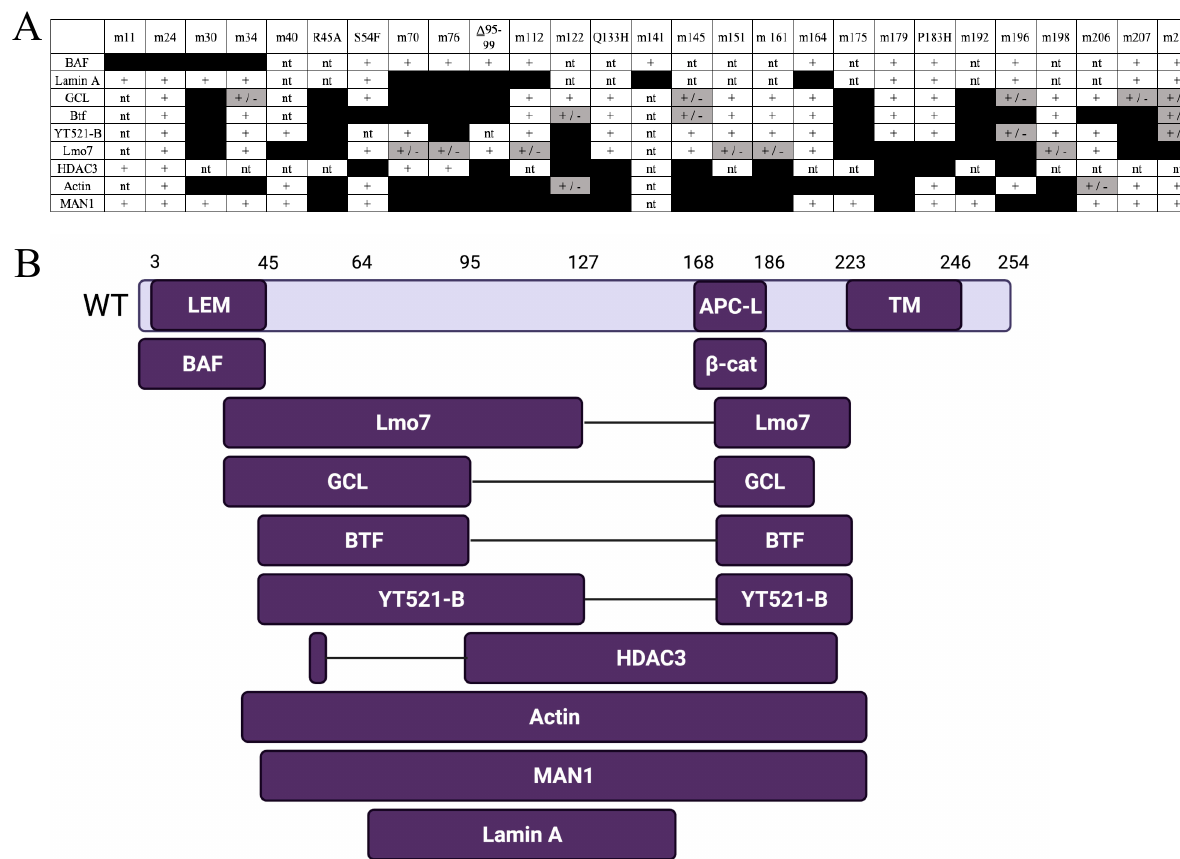
Figure 2. Functional map based on emerin missense mutations that disrupt binding to specific partners. ( A ) Summary of binding results for each named partner, tested for binding to each mutation. Scoring: Normal binding (+), weakened binding ( ± and gray), and undetectable binding (black box). nt, not tested. ( B ) Results from ( A ) mapped to the emerin polypeptide. APC-L, APC-like domain; TM transmembrane domain; LEM, Lap2, emerin, MAN1, domain [58]. Created with BioRender.com.